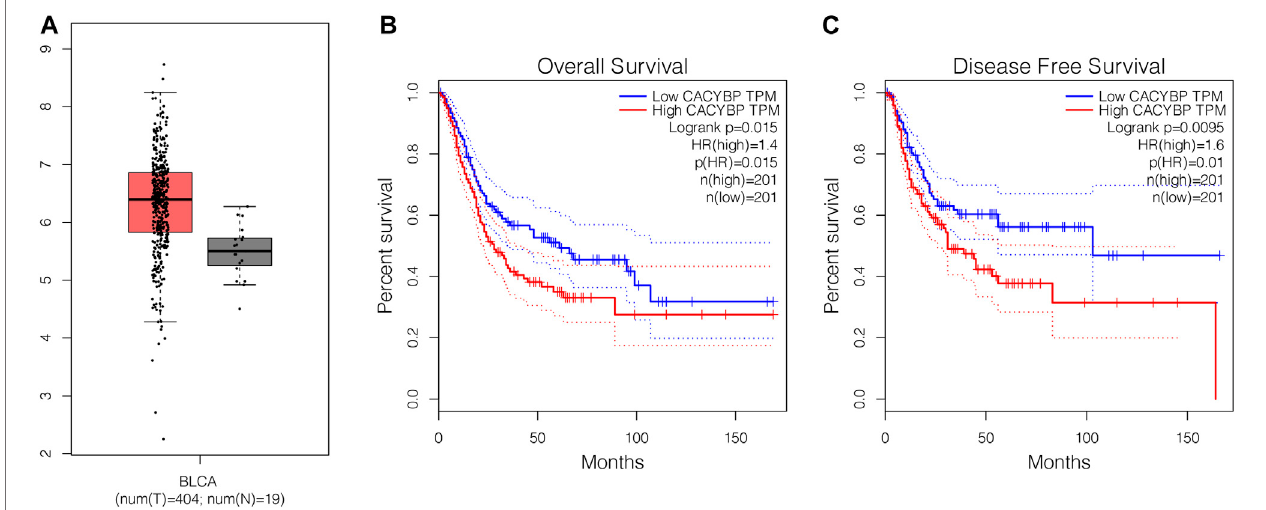
FIGURE 1 | The mRNA level of CacyBP was signi fi cantly increased in bladder cancer tissues (A) CacyBP expression levels in tumor and adjacent tissues from TCGA database (B) The Kaplan – Meier survival curves of CacyBP in bladder cancer tissues from TCGA database (C) The disease-free survival curves of CacyBP in bladder cancer tissues from TCGA